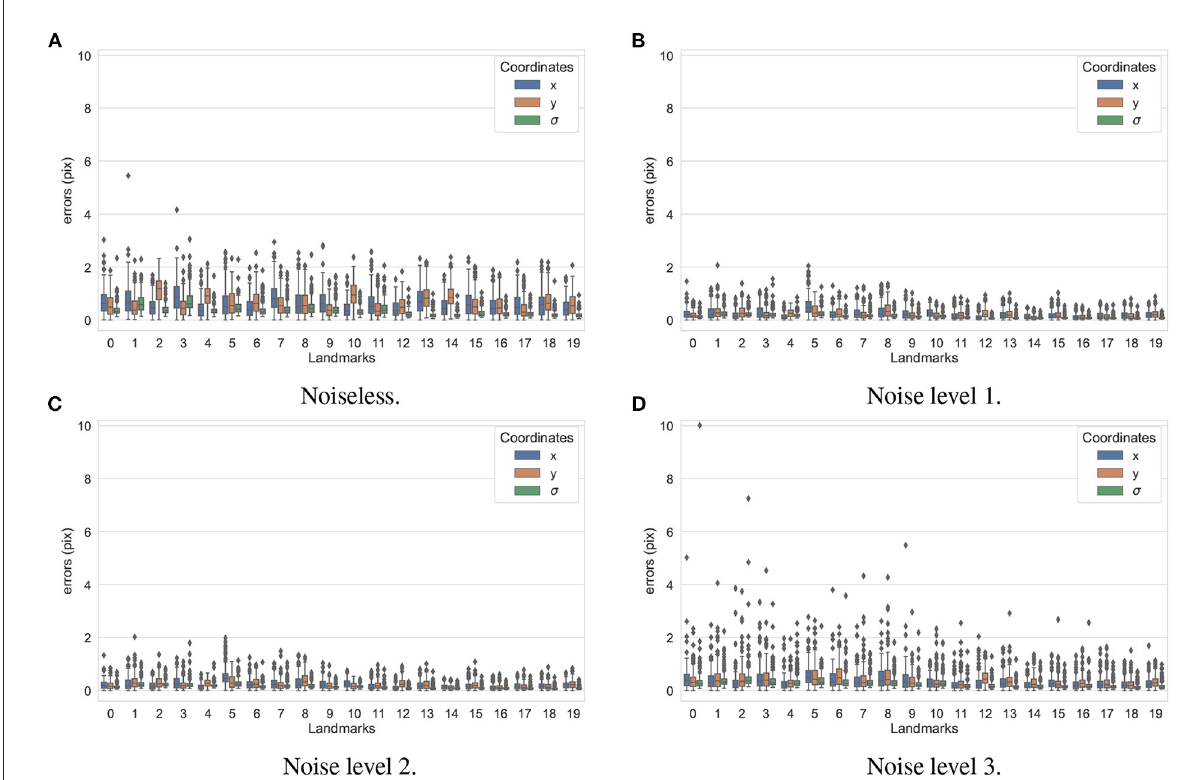
FIGURE10 2D landmark extraction errors for four datasets with different noise levels using BoneNet trained with a dataset of noise level 1. With a higher third-quartile of around 1.4 pixels, the noiseless dataset was estimated less accurately than the noisy datasets as they have the third-quartiles of < 0.8 pixels. However, there are higher numbers of outliers distributed in broader ranges in the results of noise level 3 (black diamond points in D ) in comparison to the other three datasets (black diamond points in A–C